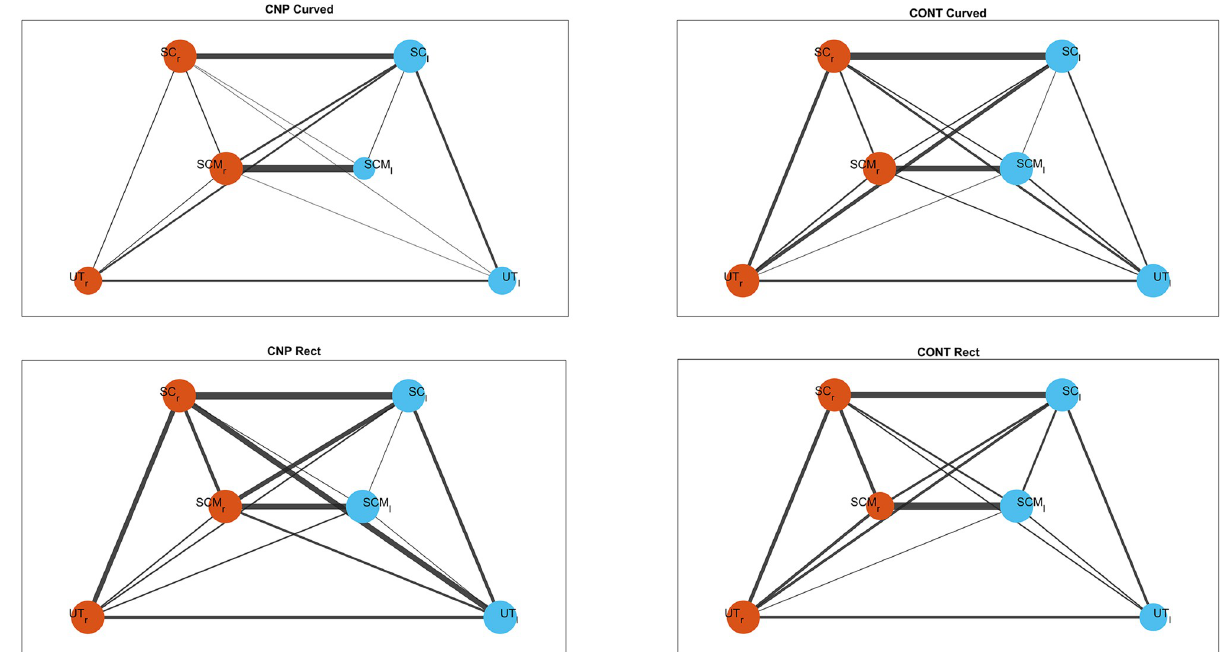
Fig 6. Functional networks of CNP and control groups during curvilinear and rectilinear task at delta band. Orange nodes represents left side muscles and blue nodes the right-side ones.